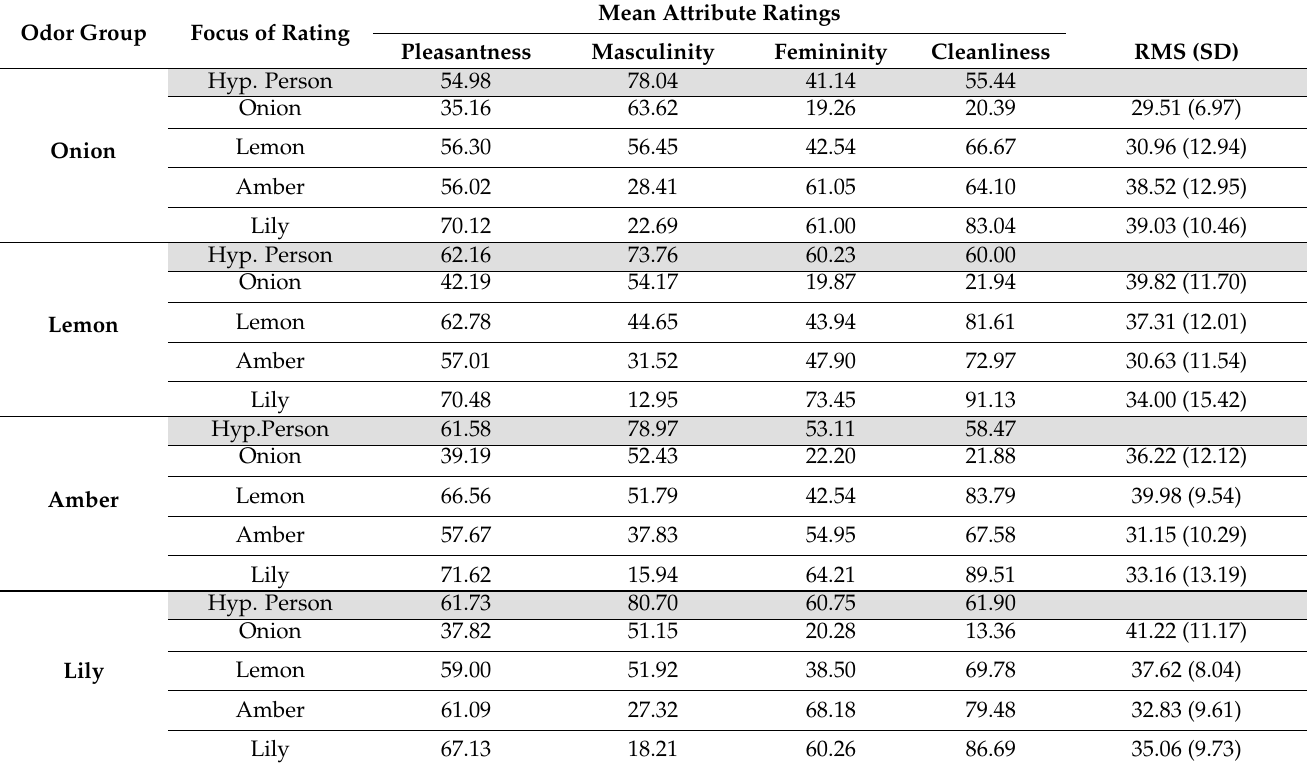
Table 2. Mean attribute ratings and mean root mean squared deviations